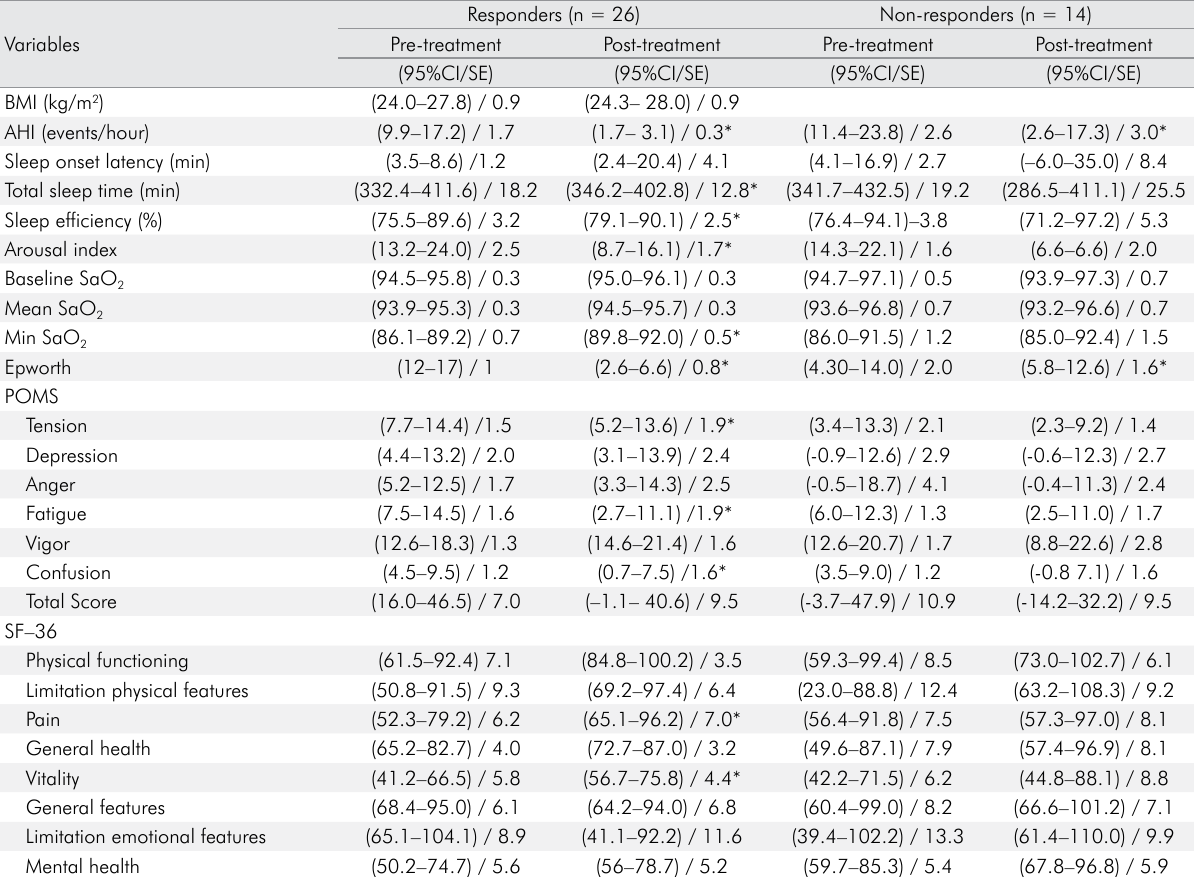
Table 3. Responders and non-responders - Pre- and post-treatment data.